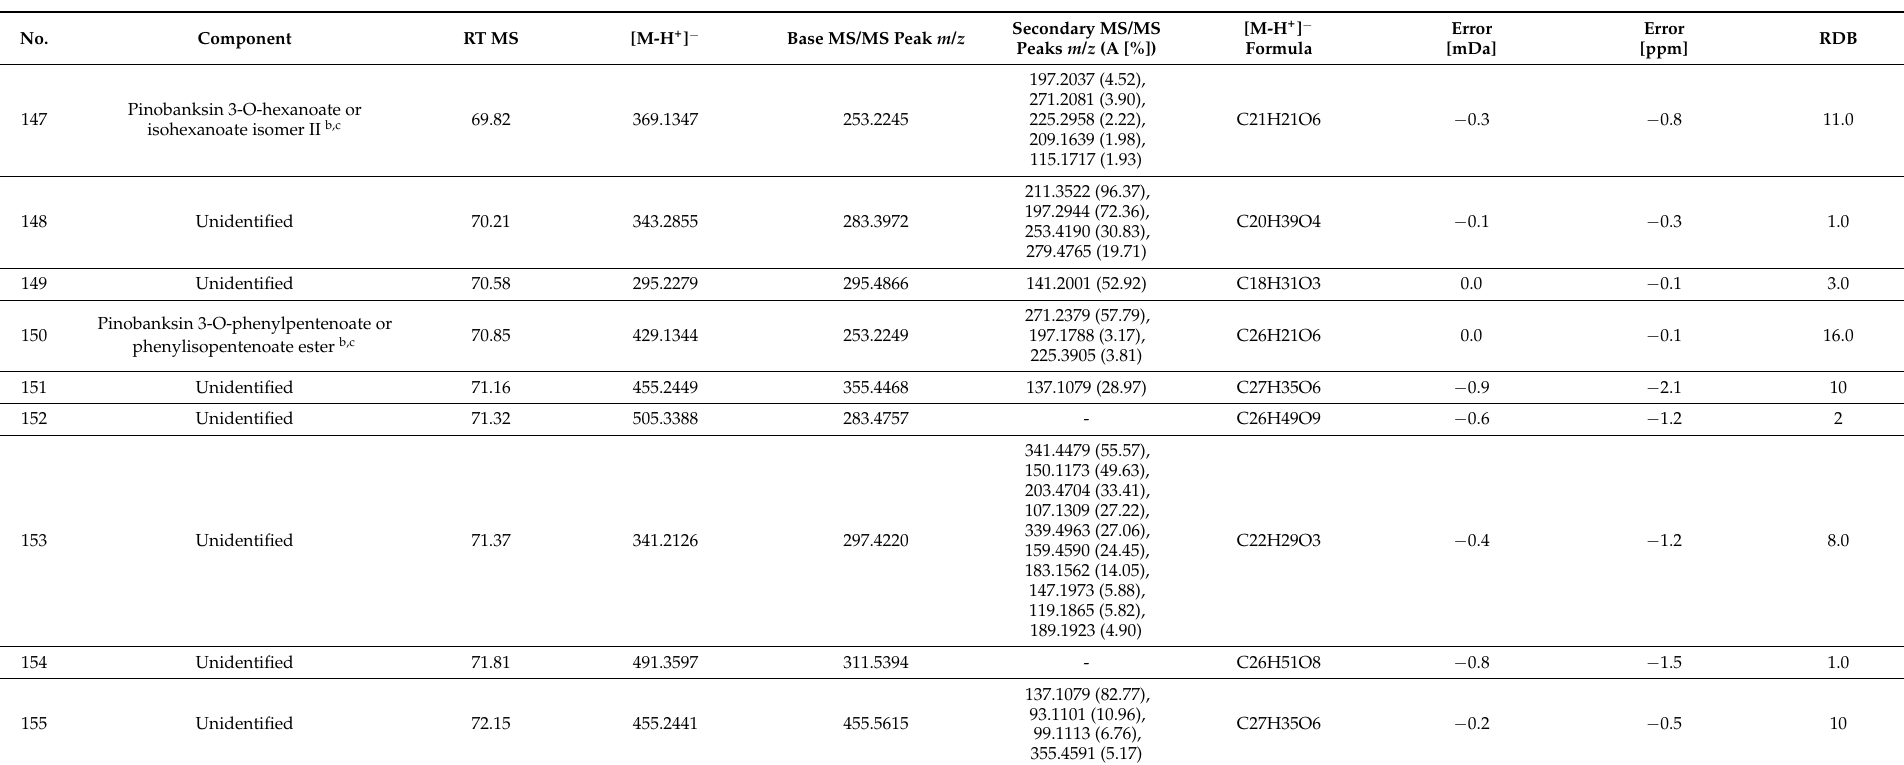
Table legend: No—number; RT MS—retention tim in uHPLC-MS/MS chromatogram; RBD—ring and double bond equivalents; a component identified by comparison with standard; b component identified by comparison with literature; c component identified by prediction of mass fragment; * component tentatively